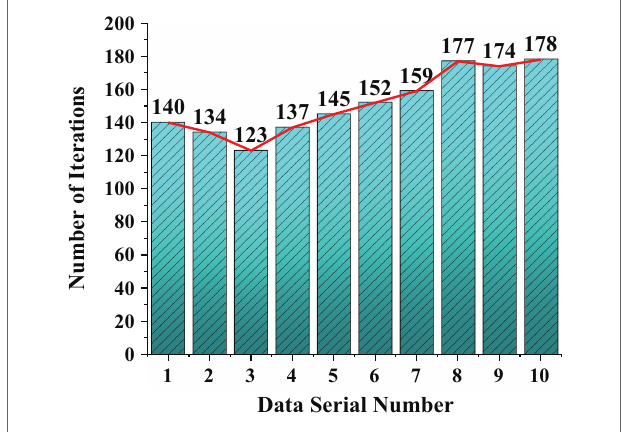
FIGURE 17 | The relationship between the weight value and the number of iterations shows the convergence